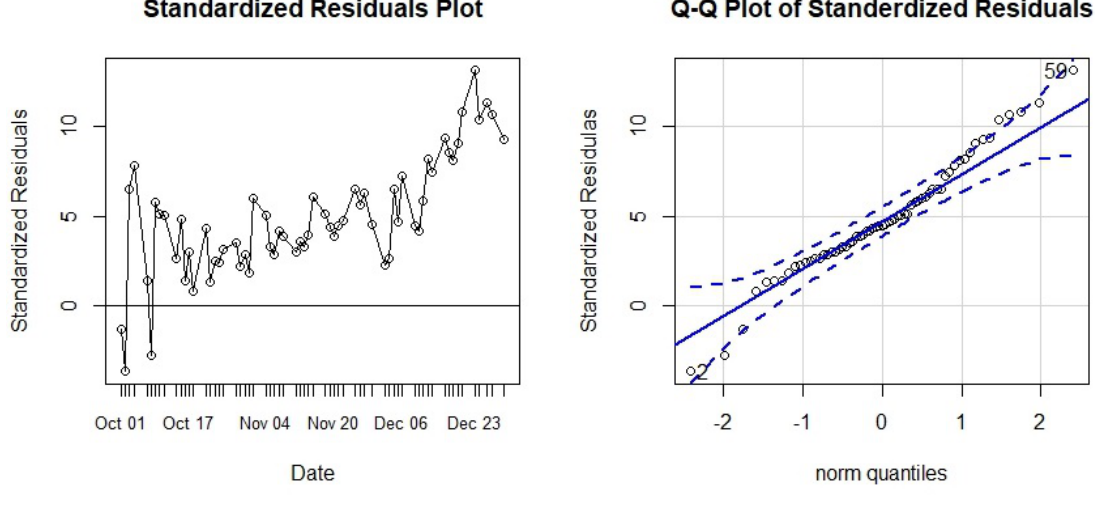
Figure 11. ANN(7-15-1) model